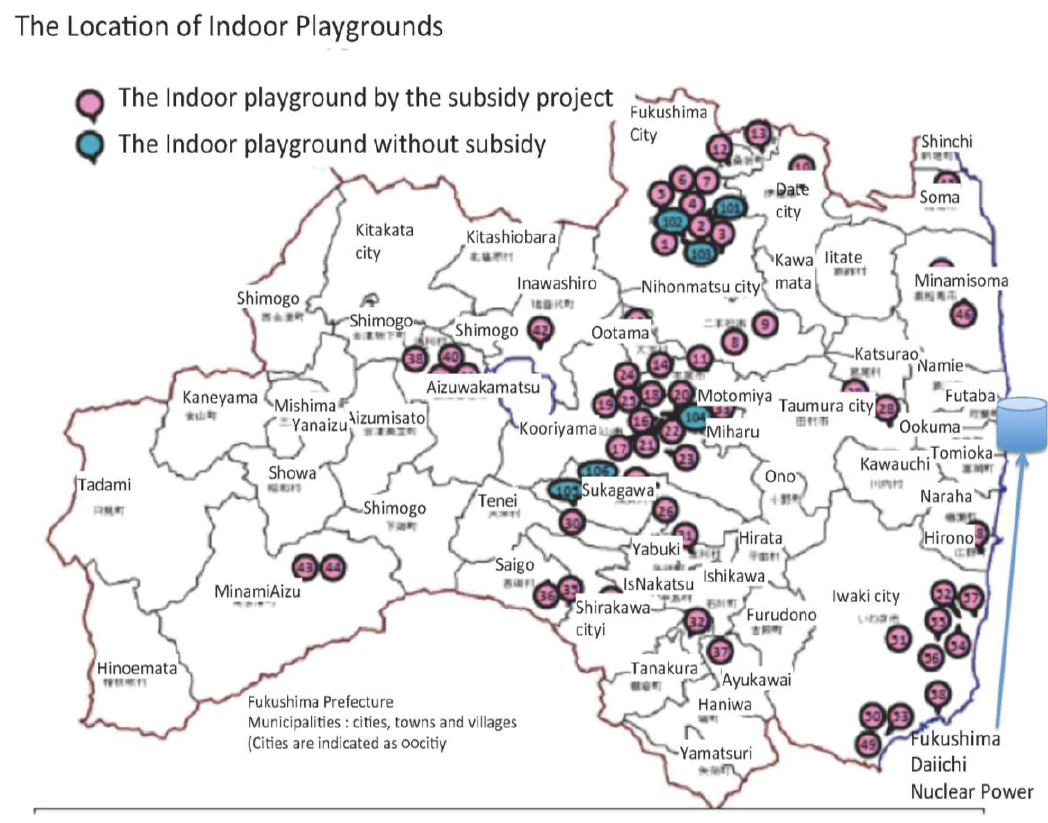
Figure 7. The location of Indoor Playgrounds in Fukushima Prefecture (source: Fukushima Prefecture 2014.4.7, This is arranged from the original map made by the department of Child Rearing Support of Fukushima prefecture with the permission to